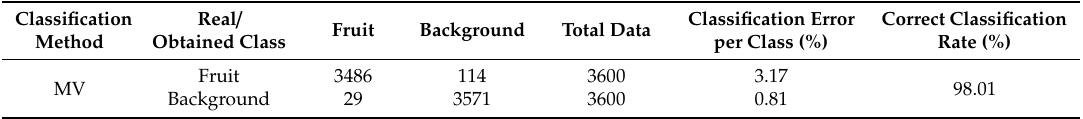
Table 10. Confusion matrices, classification error per class, and correct classification rate (CCR) in the best state of training of the majority voting (MV) method for the testing